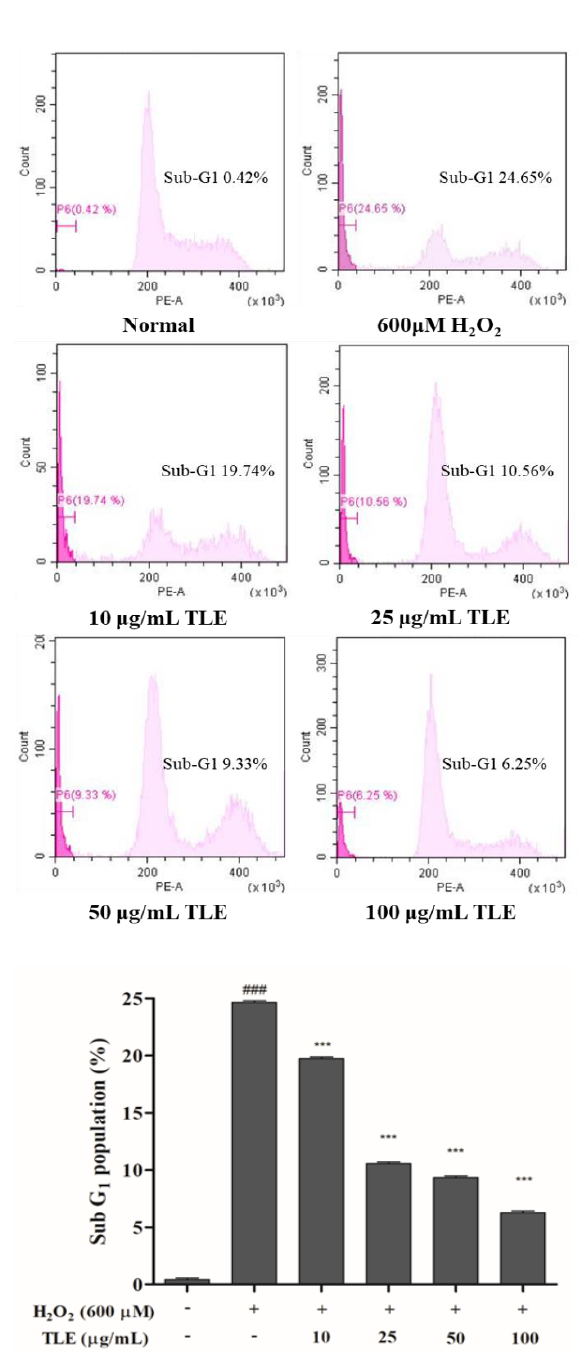
Figure 4. Proportion of sub-G1 phase cells in H 2 O 2 -treated and/or TLE-treated Vero cells. The data were measured in triplicate and expressed as the mean ± SE. *** p < 0.001 compared with the H 2 O 2 -treated group and ### p < 0.001 compared with the untreated group3.5. Nuclear Staining with Hoechst 33342 and PI.